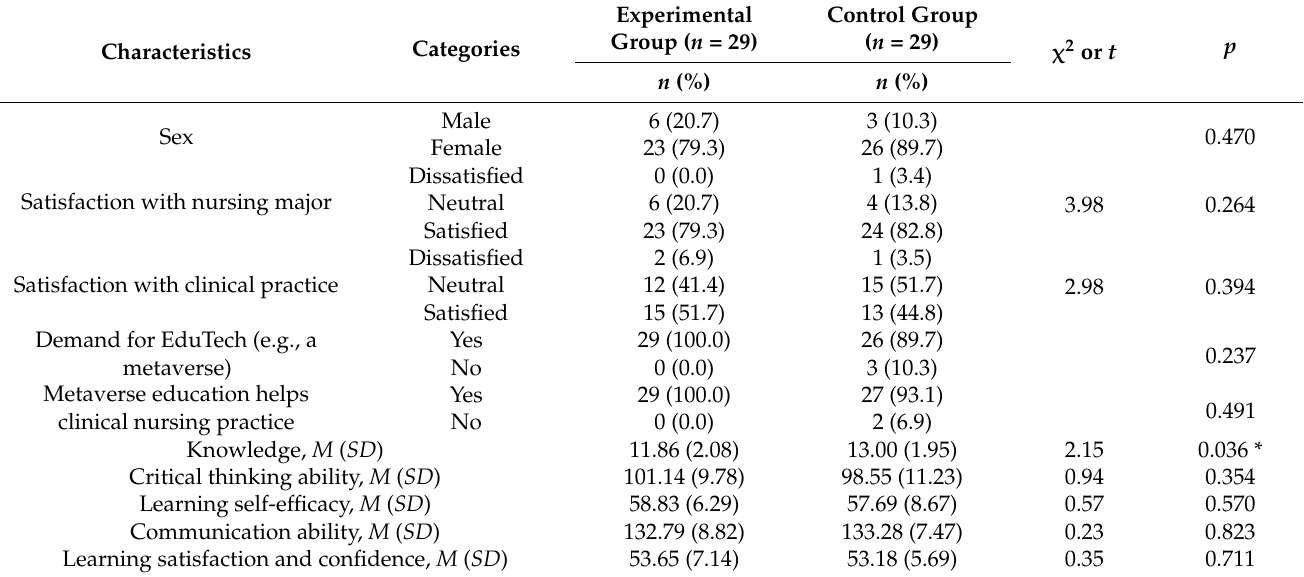
Table 3. Homogeneity test of general characteristics of participants and dependent variables ( N =